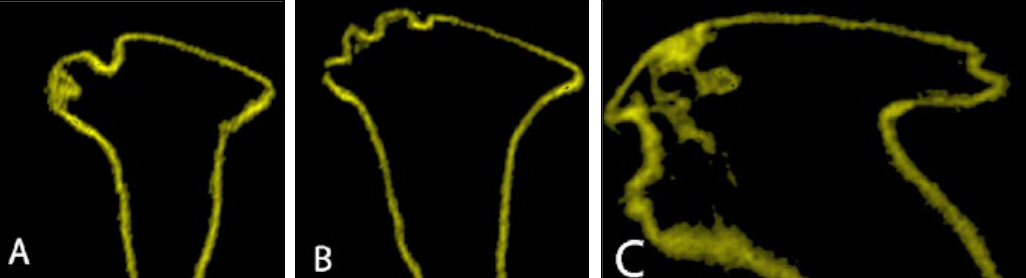
Figure 5. 2D cartilage imaging of condyle at Day 28, after both bite-jumping appliance and supplementation.